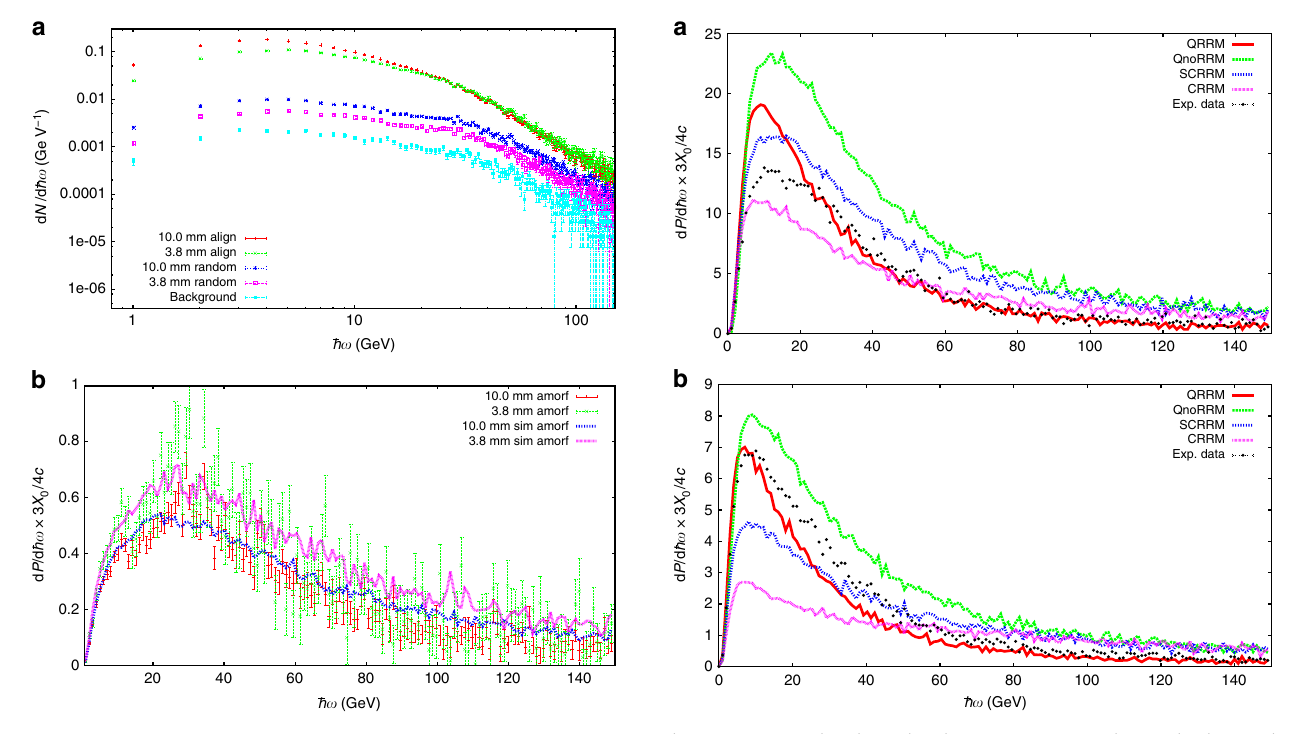
Fig. 2 Experimental and simulated counting spectra in random orientation. Photon-counting spectra per single incoming positron for the two crystal thicknesses indicated in the text in the aligned and the random case along with a measurement of the background radiation ( a ). The background subtracted power spectrum in the random orientation is compared to simulations ( b ). The error bars are due only to the statistical counting error